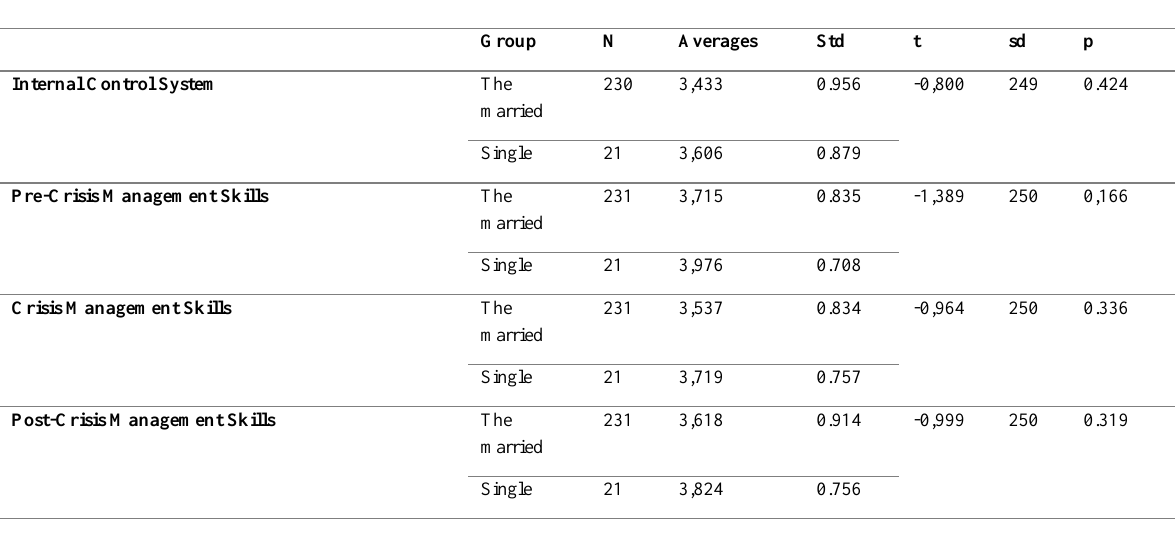
Table 8: T-Test Differentiation Status of Participants' Internal Control System and Crisis Management Scores According to Their Marital Status